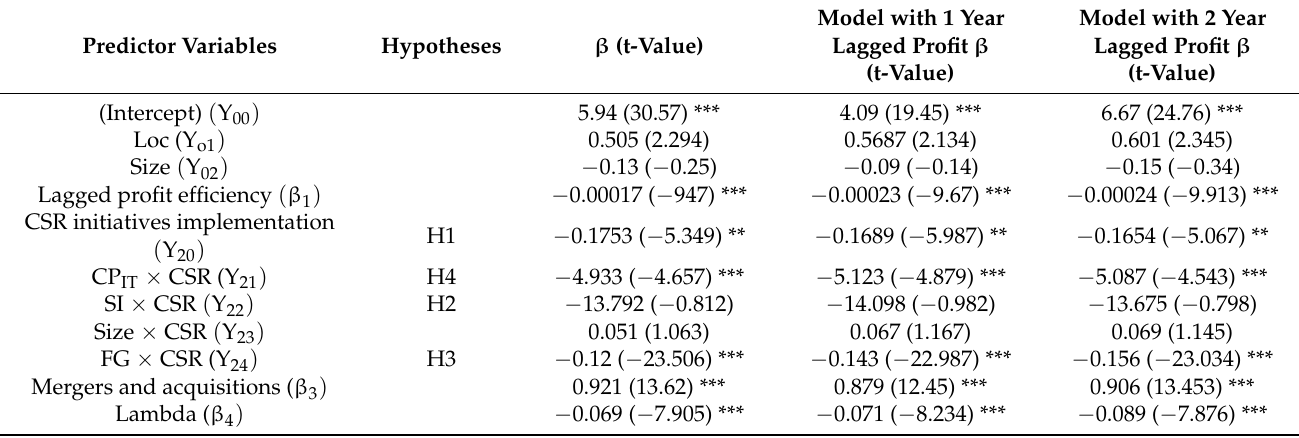
Table 4. The final results of model estimation hypothesis